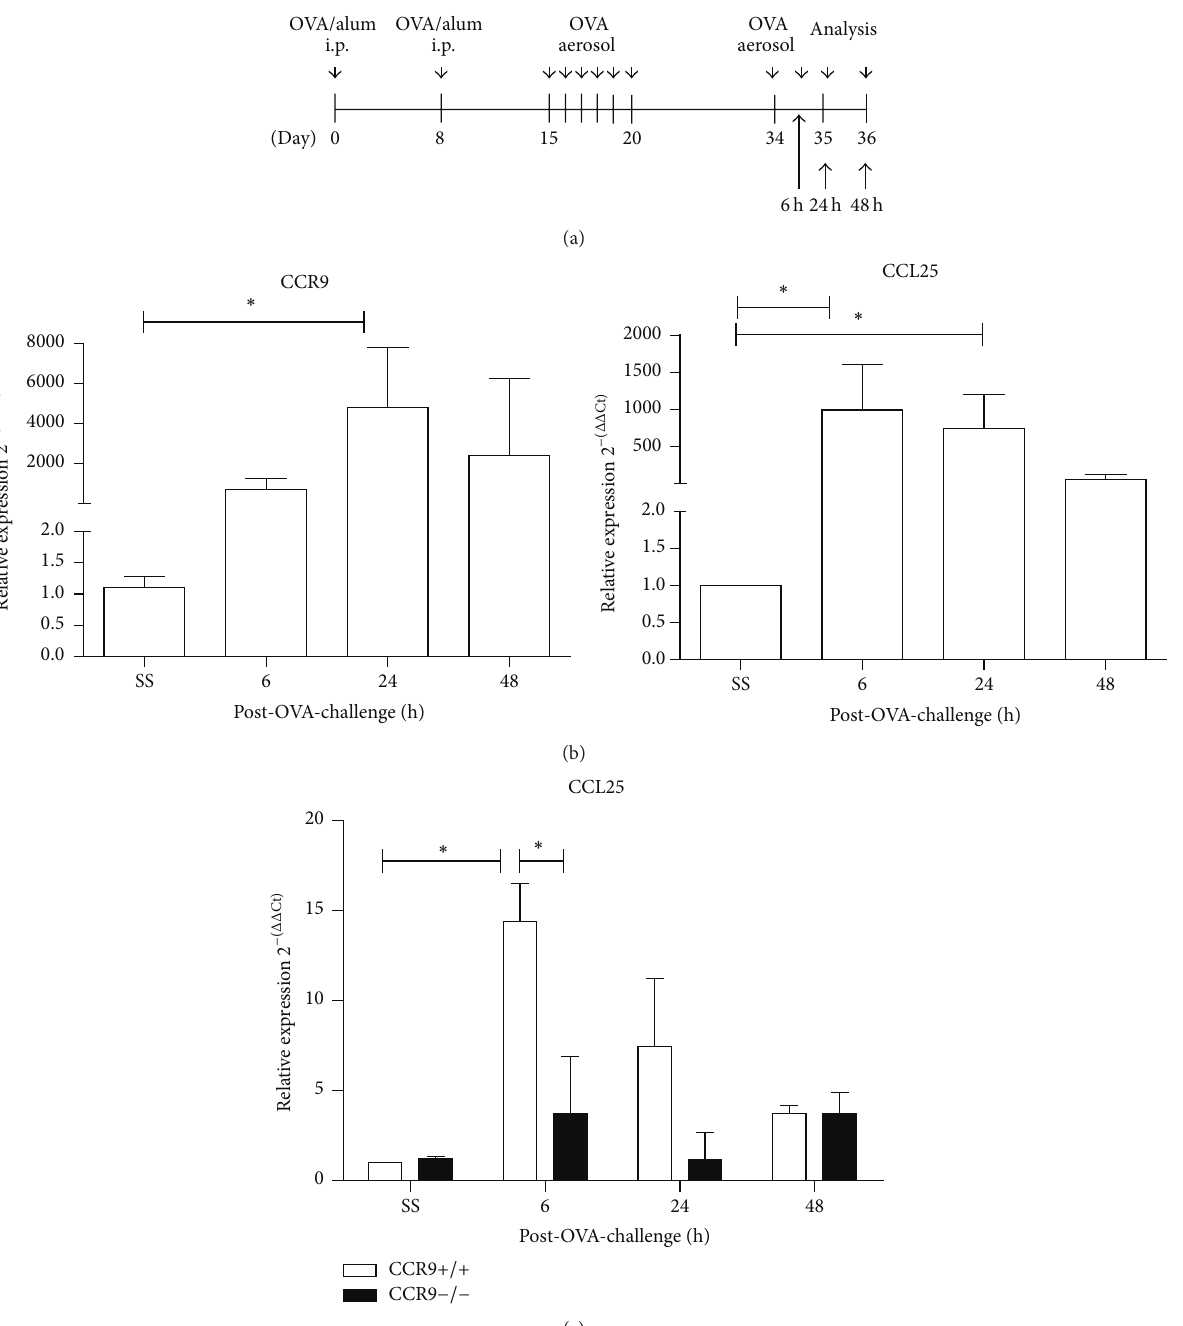
Figure 4: CCL25 expression in the lungs of allergen sensitized mice. (a) Mice were sacrificed 6, 24, and 48 h, respectively, after the last OVA- challenge. (b) CCR9 and CCL25 expression in lungs were quantified by real-time RT-PCR. (c) CCL25 expression in lungs of CCR9 KO and WT mice. Data are representative of 3 independent experiments and represent mean ± SD. 𝑛 = 2 -3 for each group ( ∗ 𝑝 < 0.05 when compared with WT mice or when compared each time with control